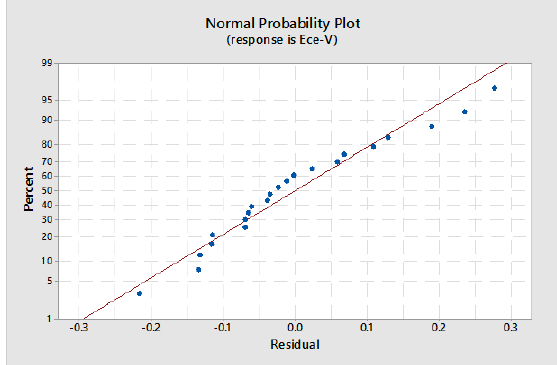
Figure 3. Multiple linear regression result of 21st March, 2010 with all bands and 22 sampled points.